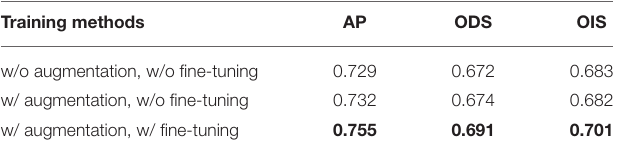
TABLE 7 | Ablation of two-stage training strategy.